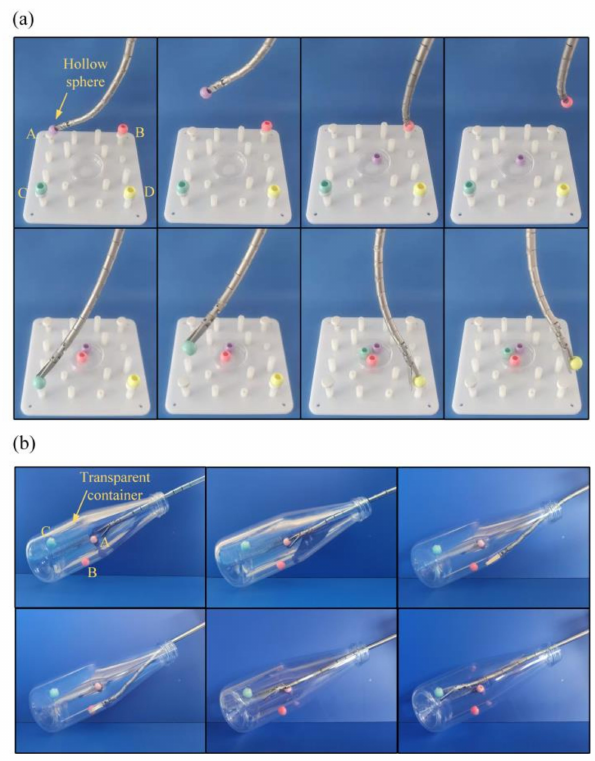
Figure 11. Operational experiments: ( a ) grasping beads with the instrument; ( b ) experiments in a narrow and long